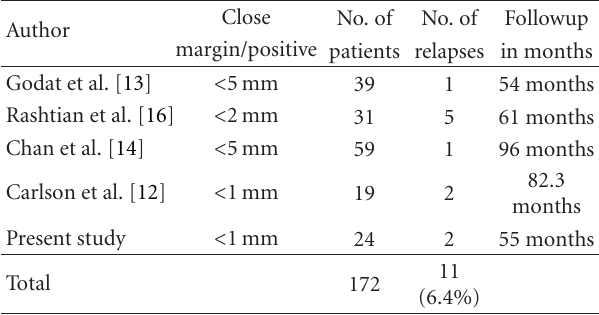
Table 3: Local-regional relapse following an unfavorable surgical resection